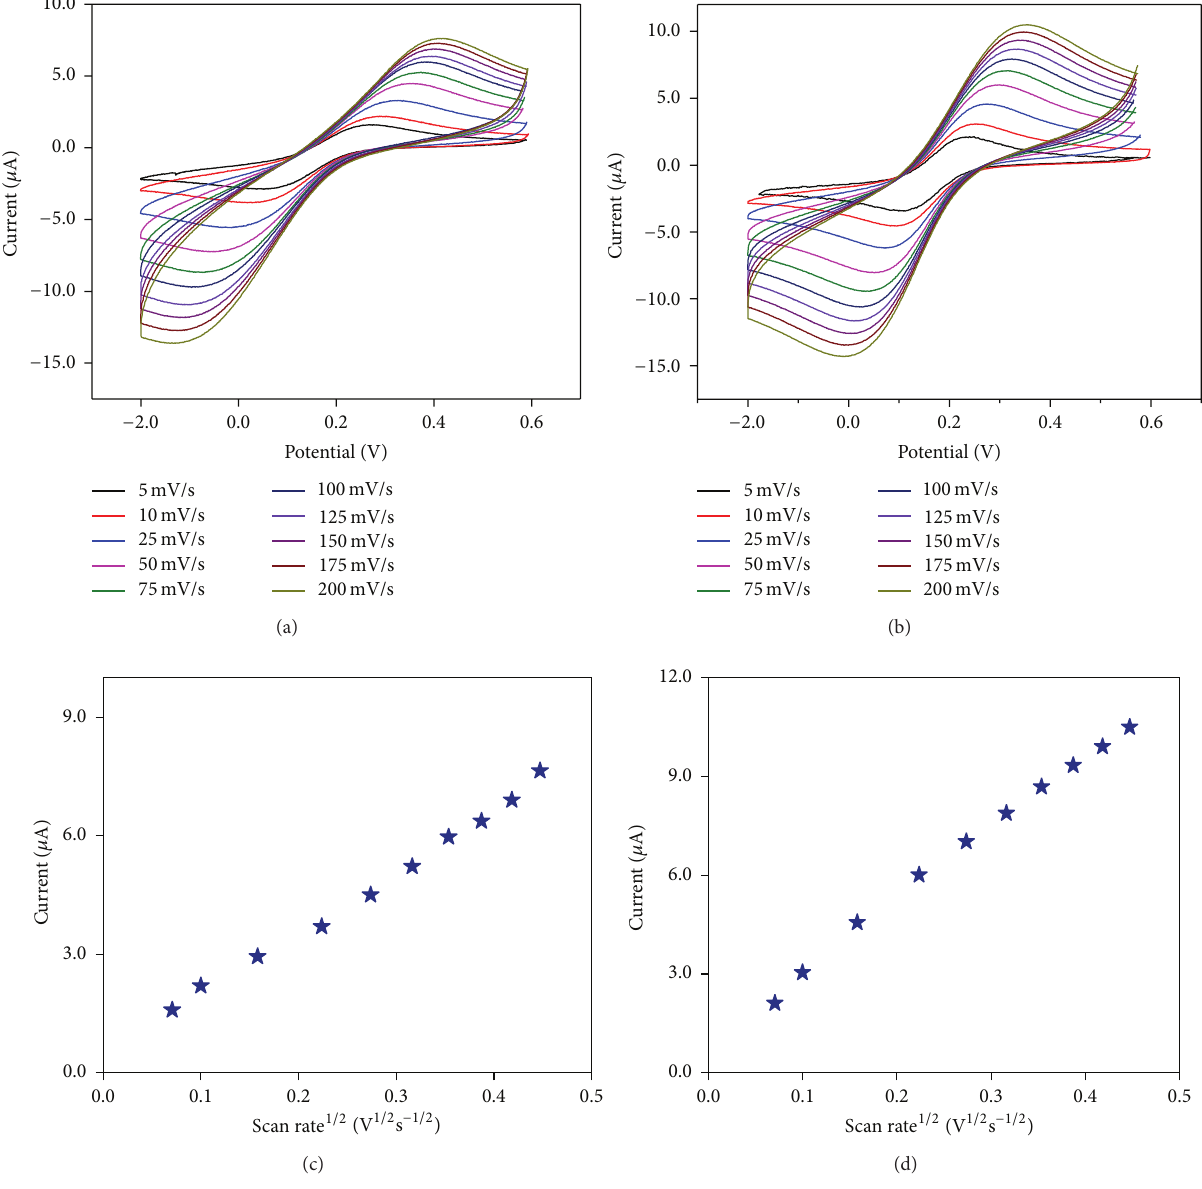
Figure 7: Cyclic voltammograms recorded at (a) bare GC and (b) 𝛼 -Fe 2 O 3 nanoparticle-modified electrode for 1 × 10 −3 M of K 3 [Fe(CN) 6 ] in 0.1M KCl at different scan rates: 5–200 mVs −1 . The plots of the anodic peak current versus scan rate 1/2 obtained for the (c) bare GC and (d) 𝛼 -Fe 2 O 3 nanoparticle-modified